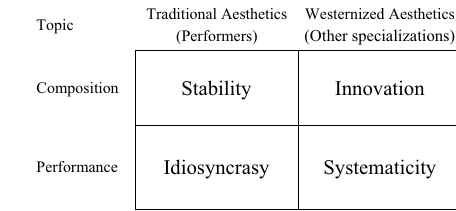
Fig. 1 Divergent frames in the Chinese traditional music